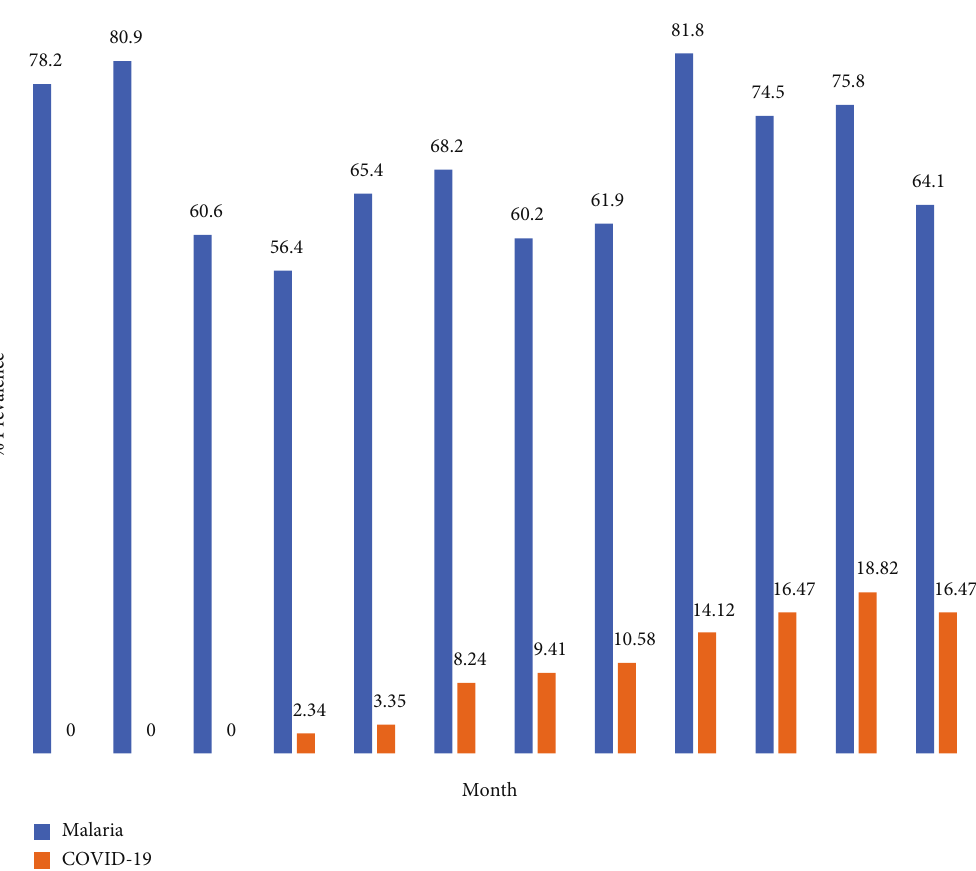
Figure 2: Percentage infection of malaria and COVID-19 in Akure North Local Government Area of Ondo State,